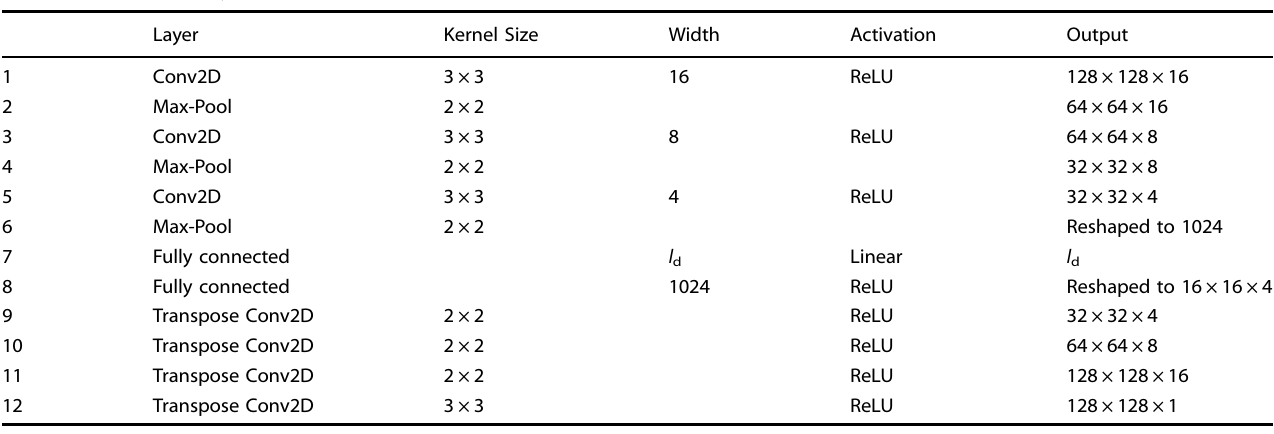
Table 1. Details of the hyper-parameters used in the convolutional autoencoder. Layer Kernel